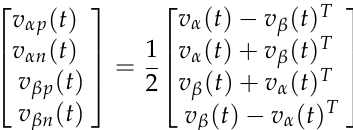
Figure 6. Control layout of FOGI .